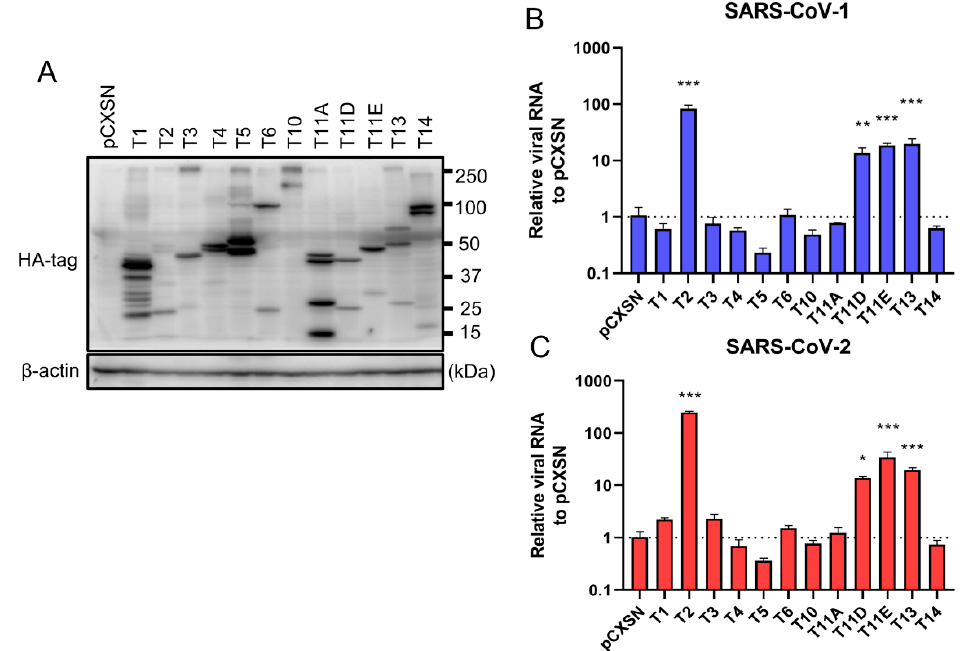
Figure 1. Entry of SARS-CoV-1 and SARS-CoV-2 in TTSP-expressing 293T-ACE2 cells. ( A ) Expression of TTSPs in 293T-ACE2 cells. Plasmids encoding TMPRSS1 (T1, 45 kDa), TMPRSS2 (T2, 53 kDa), TMPRSS3 (T3, 49 kDa), TMPRSS4 (T4, 48 kDa), TMPRSS5 (T5, 50 kDa), TMPRSS6 (T6, 89 kDa), TMPRSS10 (T10, 116 kDa), TMPRSS11A (T11A, 48 kDa), TMPRSS11D (T11D, 46 kDa), TMPRSS11E (T11E, 48 kDa), TMPRSS13 (T13, 61 kDa), TMPRSS14 (T14, 95 kDa), and empty plasmid pCXSN (as a control) with a C-terminal HA tag were transiently transfected into 293T-ACE2 cells. Protease expressions in cell lysates were detected by immunoblotting with an anti-HA antibody. Detection of β -actin was employed as a loading control. Similar results were obtained in three independent experiments. ( B , C ) Twelve types of TTSP-transfected 293T-ACE2 cells were infected with SARS-CoV-1 ( B ) and SARS-CoV-2 ( C ). Total RNAs were extracted from cells at 4 hpi and analyzed by qRT-PCR. Levels of N gene of SARS-CoV-1 and SARS-CoV-2 were normalized with that of β -actin mRNA. The values in the graphs are shown as means ± S.D. of triplicates. One-way ANOVA with Dunnett’ s test was used to determine the statistical significance compared to no-TTSPs controls; * p < 0.05, ** p < 0.01, *** p < 0.001. Data are representative of two independent